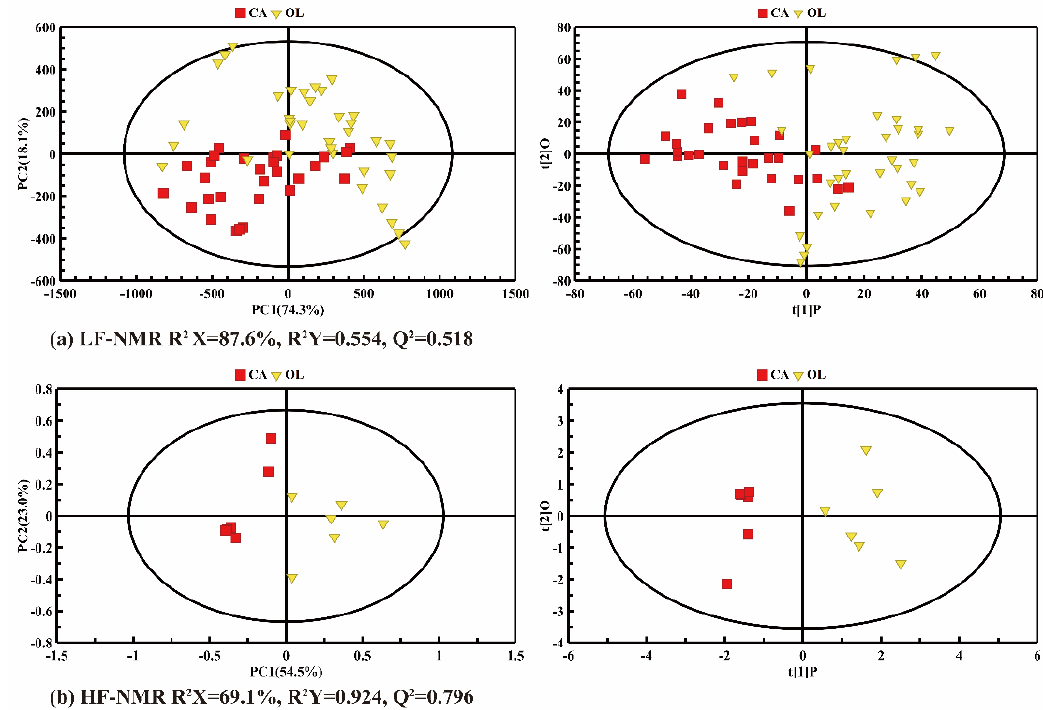
Figure 3. The PCA (left panel) and PLS-DA (right panel) score plots of the camellia oil (CA) and olive oil (OL) based on LF-NMR data ( a ) and HF-NMR data ( b ).